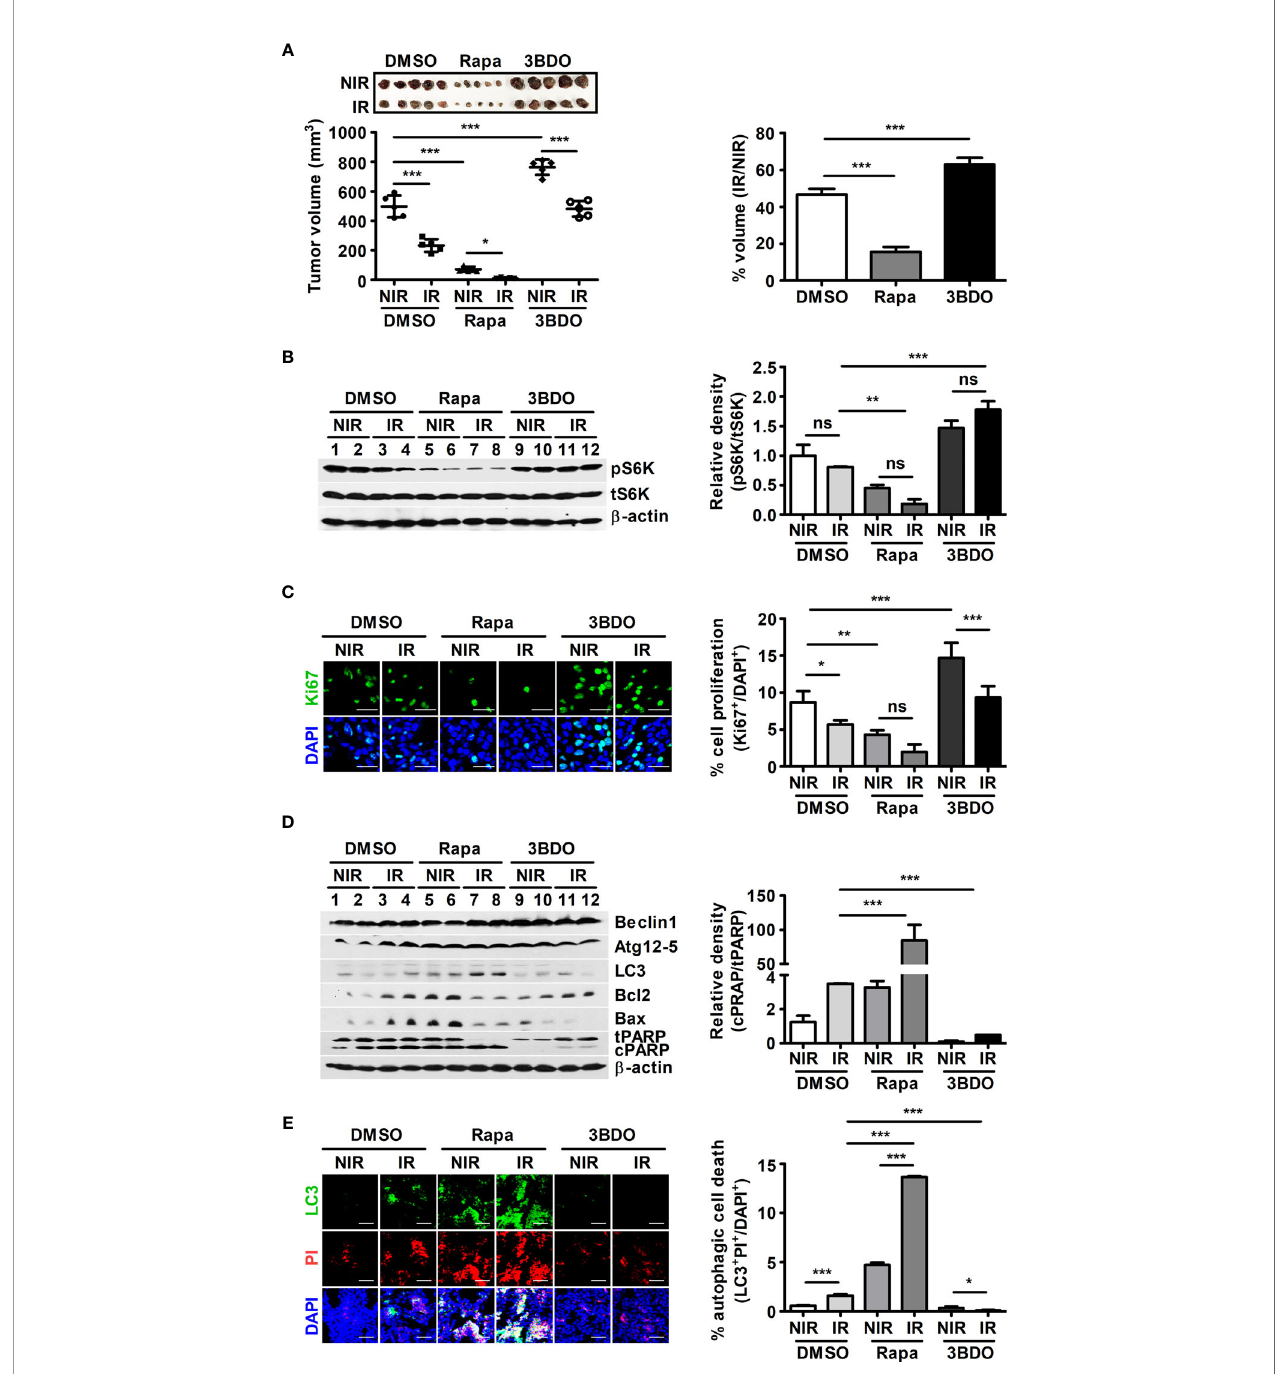
FIGURE 1 | Pharmaceutical regulation of mTOR activation affects B16F10-tumor development. (A) After tumor resection, all tumors were measured with calipers to calculate tumor volumes (left). To evaluate tumor radiosensitivity, percentages were calculated by dividing the volume of irradiated tumors (IR) by the volume of nonirradiated tumors (NIR) in each group (right). (B) The protein levels of p70 S6K, phospho-p70 S6K, and b -actin in homogenized tumor tissue samples were evaluated by western blotting. The relative density of phosphorylated forms was measured using ImageJ. (C) Intratumoral levels of Ki67 were analyzed by confocal microscopy. Nuclei (blue) and proliferating cells (green) were stained with DAPI and an anti-Ki67 antibody, respectively. Scale bars, 30 m m. (D) The protein levels of Beclin1, Atg12-5, LC3, Bcl2, Bax, PARP, and b -actin in homogenized tumor tissue samples were evaluated by western blotting. (E) Intratumoral levels of LC3 (green) were assessed by confocal microscopy. Nuclei (blue) and damaged cells (red) were stained with DAPI and propidium iodide, respectively. Scale bars, 100 m m. The bars and error bars represent the mean ± SD; * P < 0.05; ** P < 0.01; *** P < 0.001; ns, not signi fi